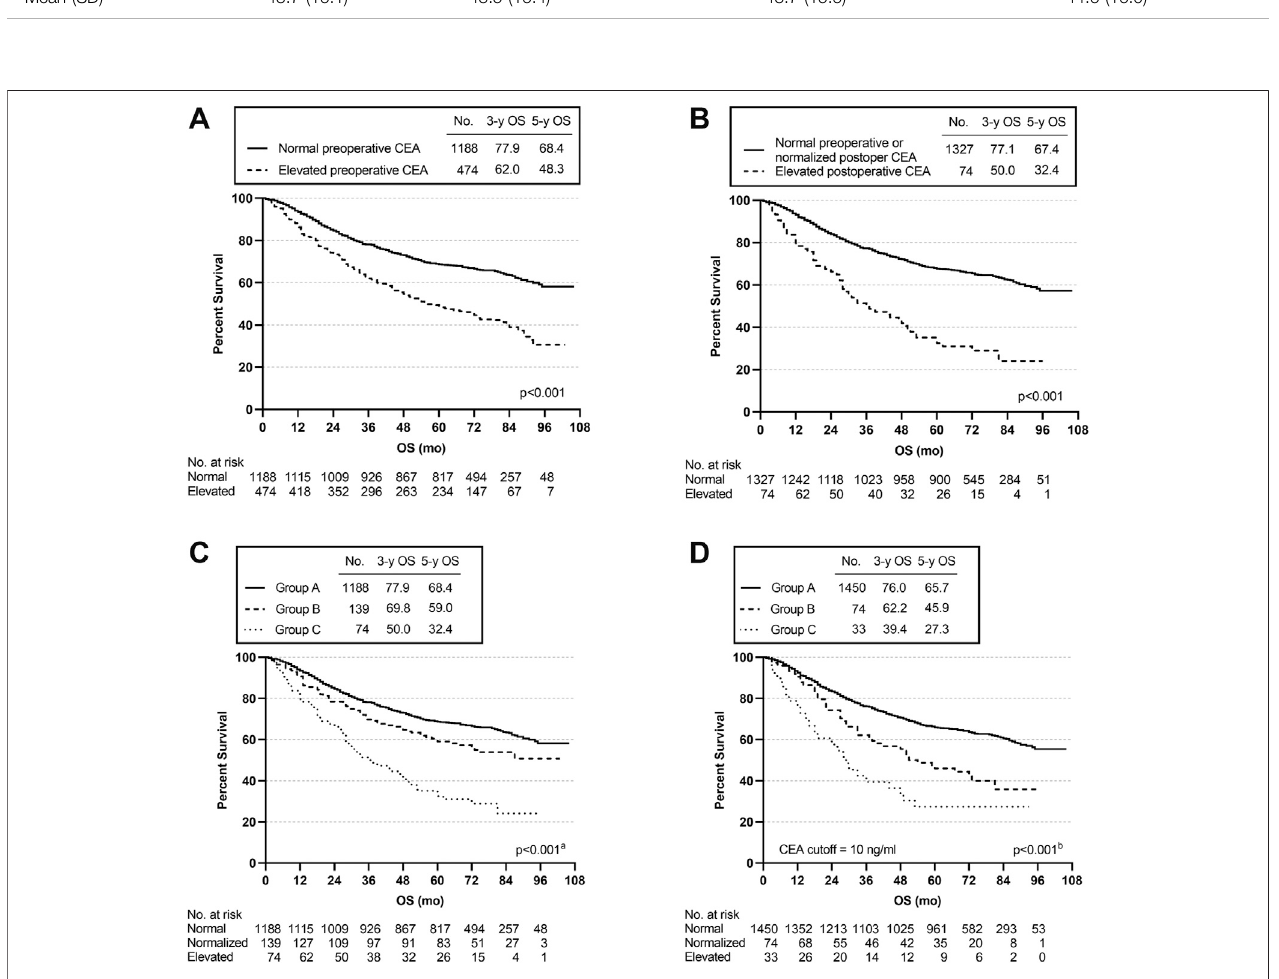
FIGURE 2 | Overall survival (OS) curves according to preoperative and postoperative CEA level. (A) K-M curve for OS in patients with normal vs. elevated preoperative CEA. (B) K-M curve for OS in patients with normal preoperative or normalized postoperative CEA vs. elevated postoperative CEA. (C) K-M curve for OS in patients with different subgroups. (D) K-M curve for OS in patients with different subgroups using a CEA cut-off of 10 ng/ml. a Group A vs. Group B, p (cid:1) 0.016; Group A vs. Group C, p < 0.001; Group B vs. Group C, p < 0.001. b Group A vs. Group B, p < 0.001; Group A vs. Group C, p < 0.001; Group B vs. Group C, p (cid:1) 0.048.